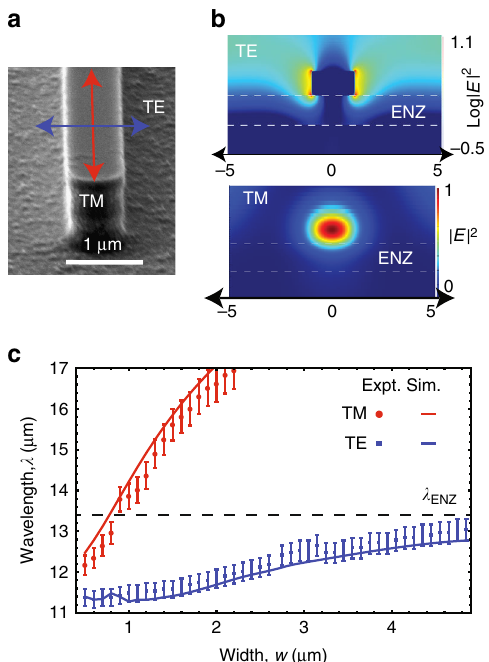
Fig. 3 Geometric dispersion of mie resonators on ENZ substrate. a Scanning electron microscopy ( SEM ) images of the etched intrinsic InSb resonators of height 1 µ m, length 500 µ m (long side) and widths 700 nm (short side) on the doped substrates. b Plot showing the resonant electric fi eld intensity pro fi les under TE-polarized and TM-polarized illumination (w.r.t the short side) of a 1 μ m wide resonator. The electric fi eld intensity is concentrated outside the resonator, at the substrate-resonator edge for the TE-polarized mode while the resonant fi elds are almost completely localized inside the resonator for the TM-polarized mode. c Plot showing the experimentally measured geometric dispersion of the TE ( blue squares ) and TM ( red dots ) resonances as function of resonator width and the error bars represent possible variation in the measurements due to the detector resolution limit. The solid lines (TE: blue and TM red ) show the FDTD simulated peaks in scattering cross section of single resonators. The TE resonance exhibits a far weaker geometric dispersion and does not cross the ENZ wavelength of the substrate ( black dashed line ), indicating a highly substrate-coupled